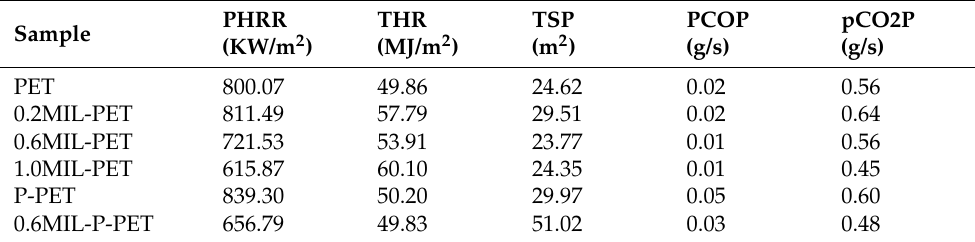
Table 4. CC results of MIL − PET and MIL − P − PET composites.